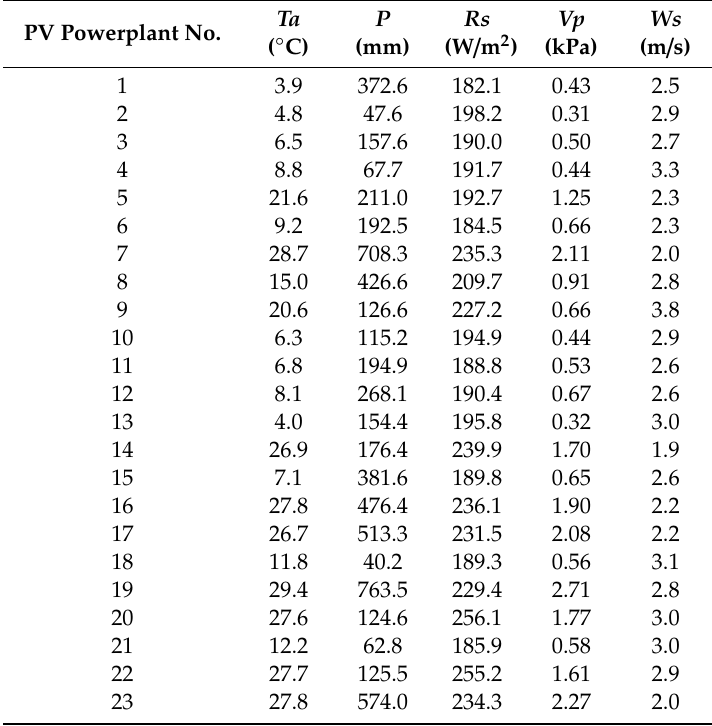
Table2. ThestatisticsofclimatefactorsofthePVpowerplants. Theairtemperature( Ta ), precipitation( P ), solarradiation( Rs ), vaporpressure( Vp )andwindspeed( Ws )werefromWorldClim(Version 2.0)dataset. PV Powerplant